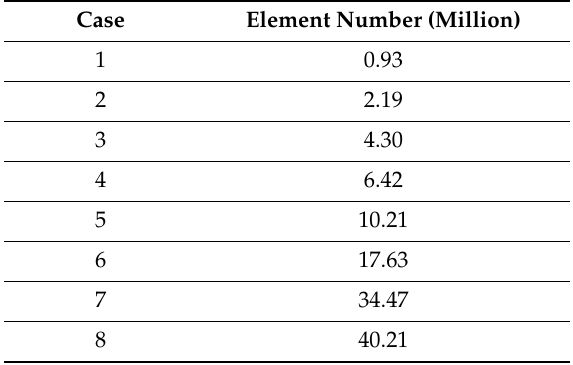
Table 1. Element numbers for mesh independence analyses.